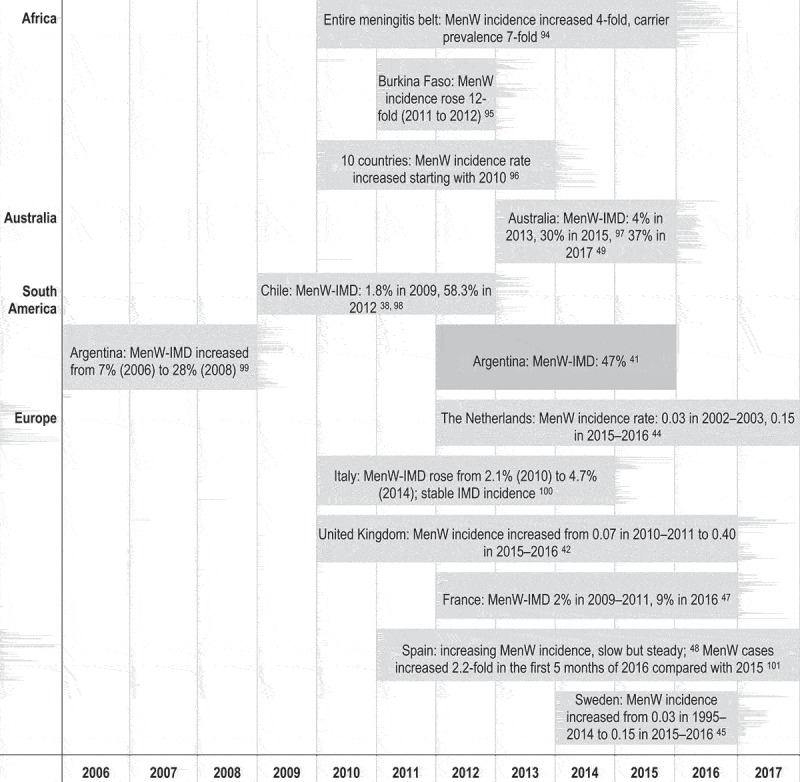
Chronological overview of changes in MenW epidemiology in the last decade (up to July 2018). IMD, invasive meningococcal disease.Note: MenW incidence rate is expressed per 100,000 population.